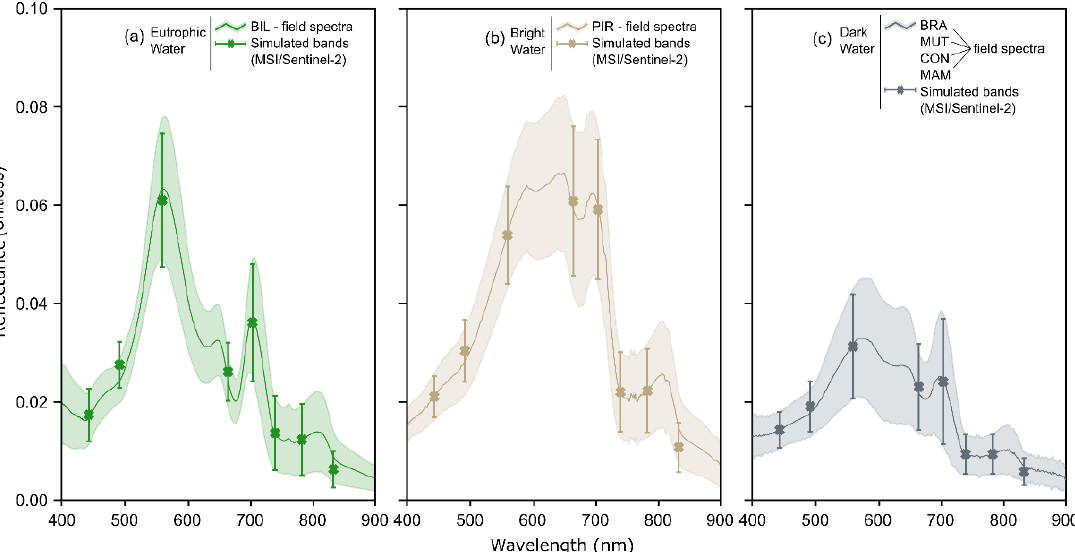
Figure 2. Spectral values of water reflectance measured in-situ for selected water bodies. The water bodies were grouped into three types: ( a ) eutrophic, ( b ) bright, and ( c ) dark waters. Solid lines and shaded areas indicate the average and standard deviation of water reflectance, respectively. The markers and error bars indicate the reflectance values simulated for the MSI sensor bands.